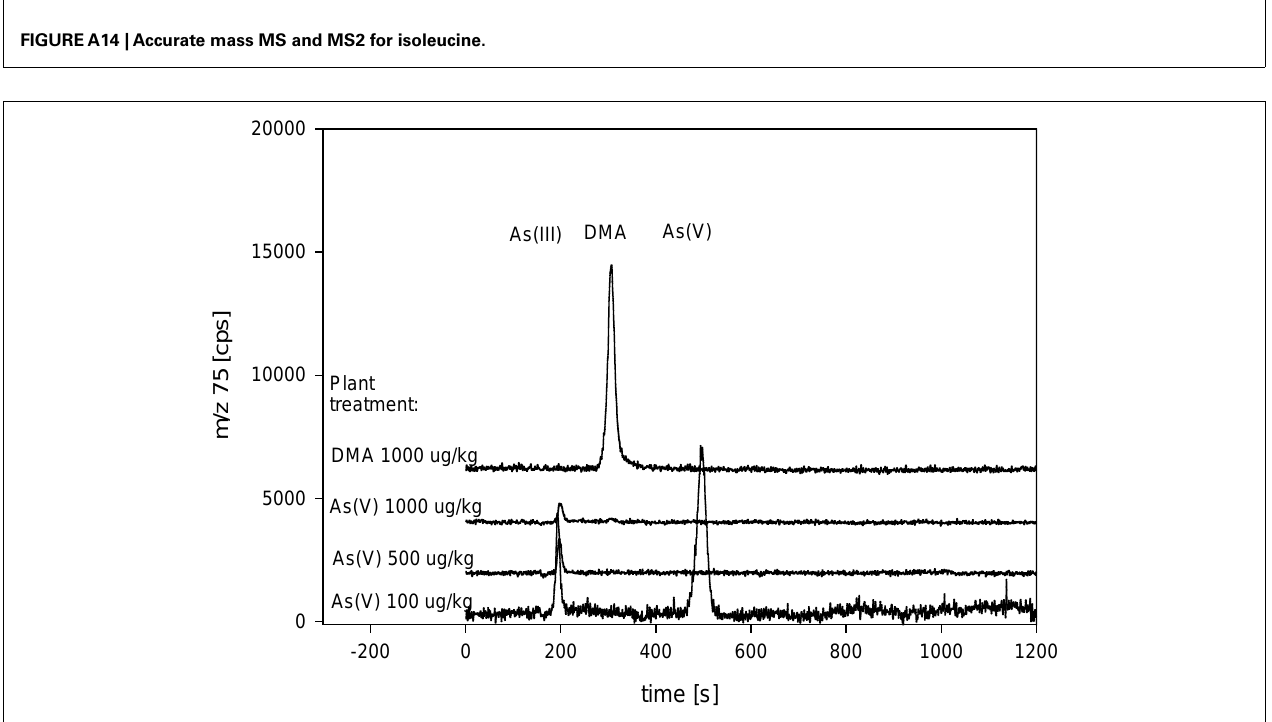
FIGUREA15 |Anion-exchange HPLC–ICP-MS chromatograms of xylem sap samples of plants challenged with 1000 μ g/kg DMAV, 100, 500, and 1000 μ g/kgAsV for 24h. Samples of 500 and 1000 μ g/kg As V had to be diluted to make up enough sample for injection. All chromatograms have an offset for clarity (Plant set